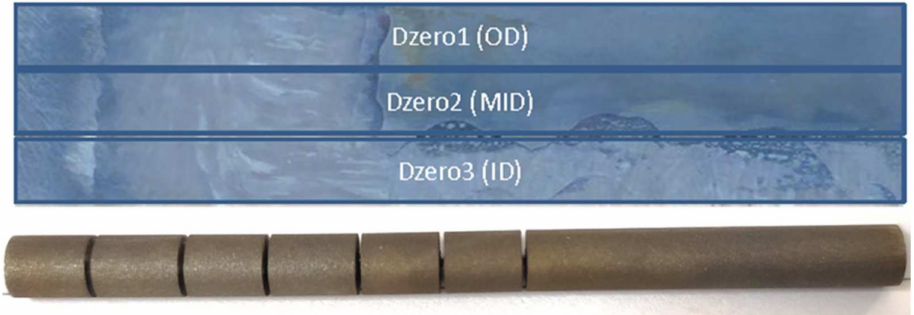
Figure 3. Macrograph of the weld joint ( top ) and the D0 samples ( bottom , grooved cylinder of 4.3 mm in diameter) machined along the OD, mid thickness (MID) and ID of the weld joint.